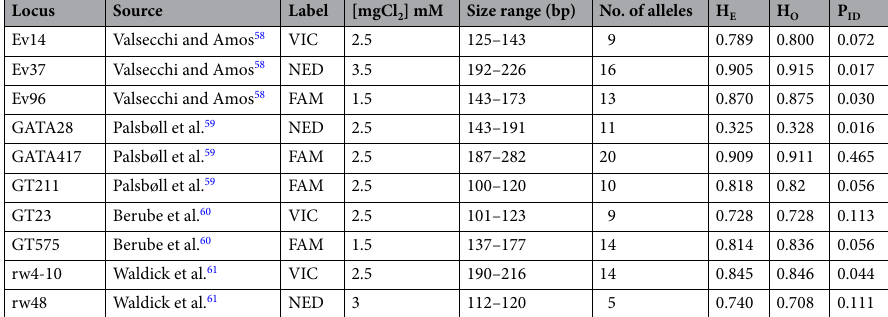
Table 2. Summary of microsatellite loci used for individual identification of humpback whales ( Megaptera novaeangliae) along the WAP 58–61 . The number of alleles observed (H O ) and expected (H E ) heterozygosity) was calculated using Cervus 3.0.1. The expected probability of identity (P ID ) of each locus was calculated with the program GenAlEx v6.5